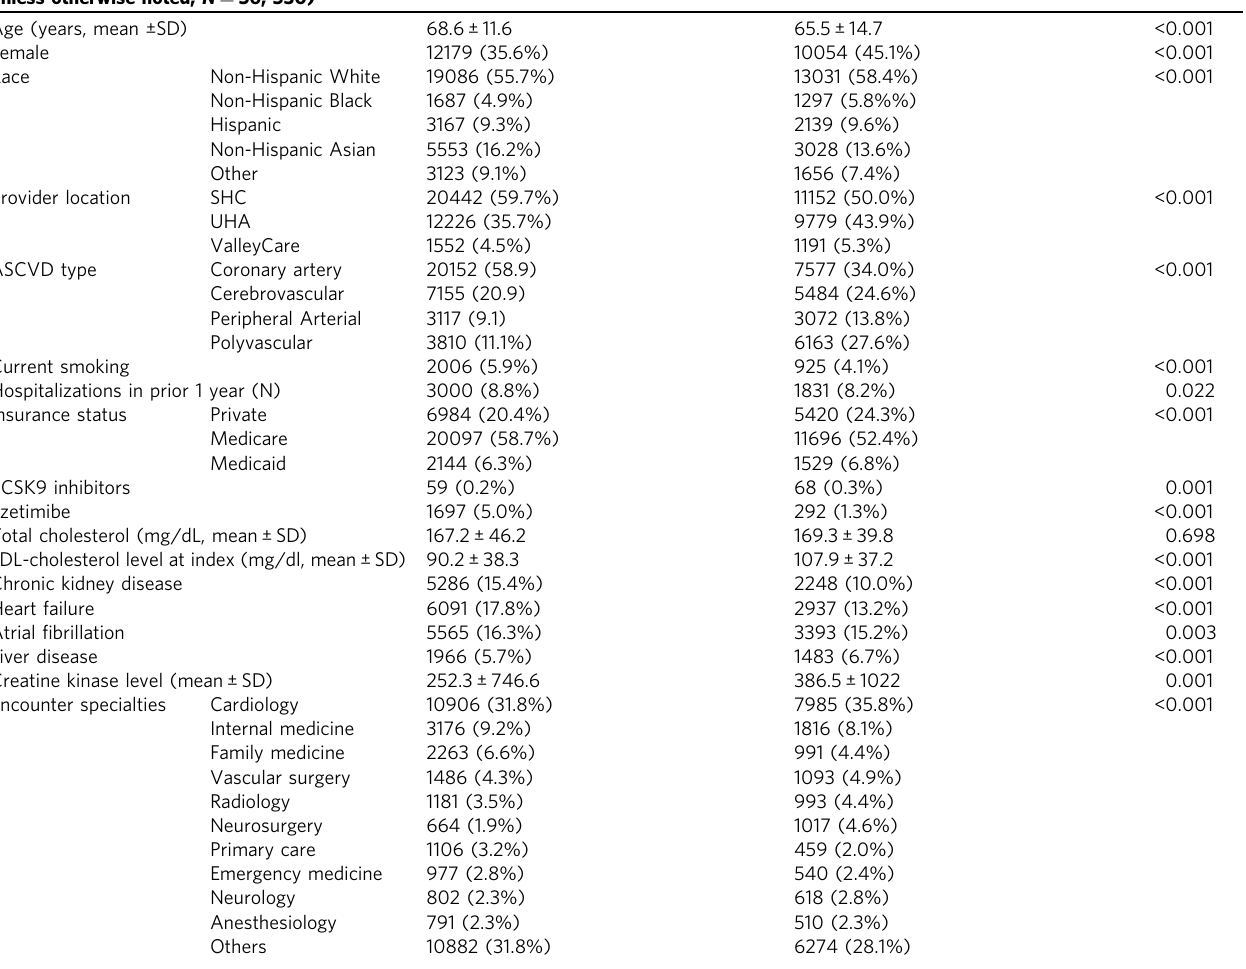
Table 1 Baseline characteristics of the ASCVD study cohort by the presence or absence of a statin prescription. Characteristic at index date ( N [% by column] unless otherwise noted; N = 56,